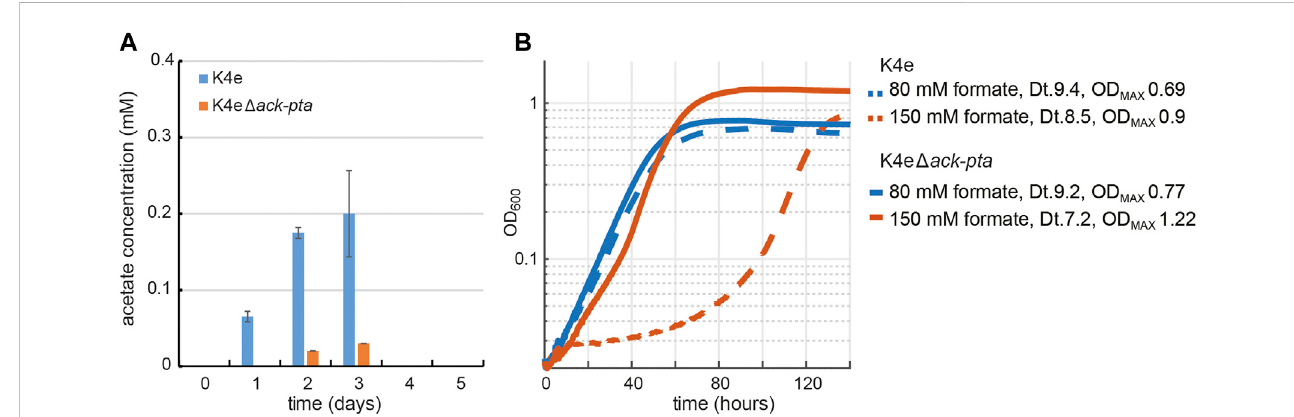
FIGURE 3 Effect of acetate over fl ow metabolism on the growth of K4e. (A) Acetate accumulation of K4e in test tubes with 90 mM initial formate. Only acetate was excreted in K4e and re-assimilated as the cell growth enters exponential phase. Strongly reduced acetate production was observed with K4e Δ ackA-pta . (B) Growth pro fi le of K4e and K4e Δ ackA-pta on 80 and 150 mM formate in 96-well plate experiments performed in triplicates, which displayed identical growth curves ( < 5% errors). Deletion of ack-pta resulted in increasing fi nal OD 600 and high formate tolerance. Dt, doubling time.